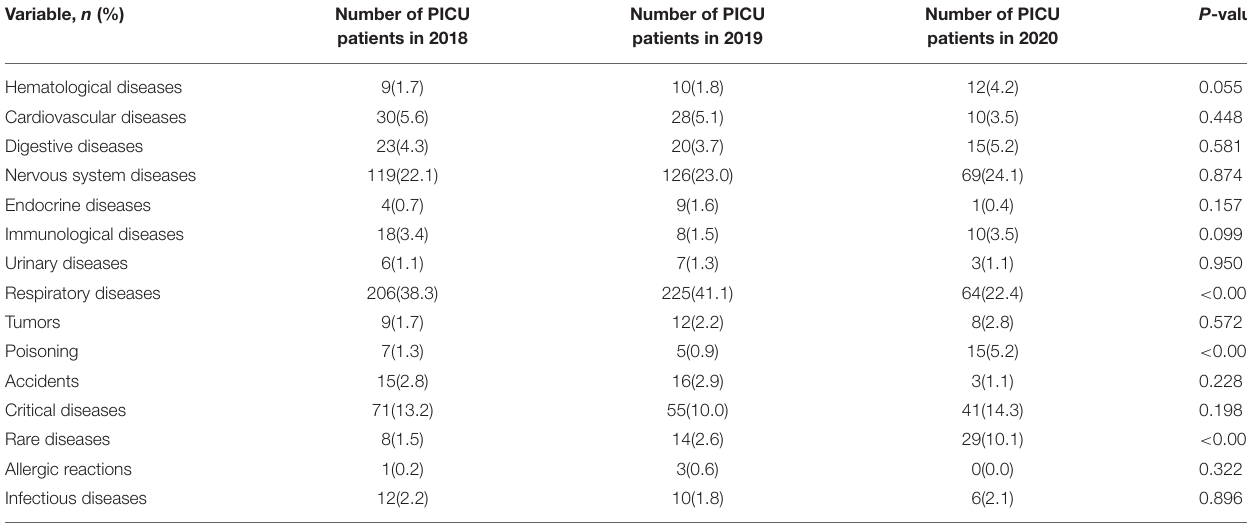
TABLE 2 | Distribution of the disease spectrum of patients admitted to the pediatric intensive care unit by year (2018–2020). Variable, n